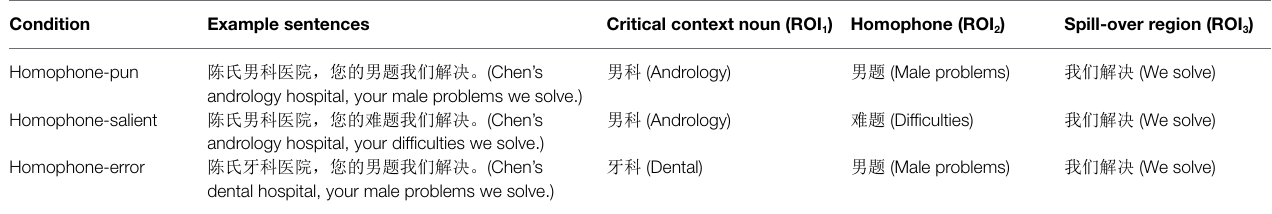
TABLE 1 | Sample sentences and the setting up of different region of interests